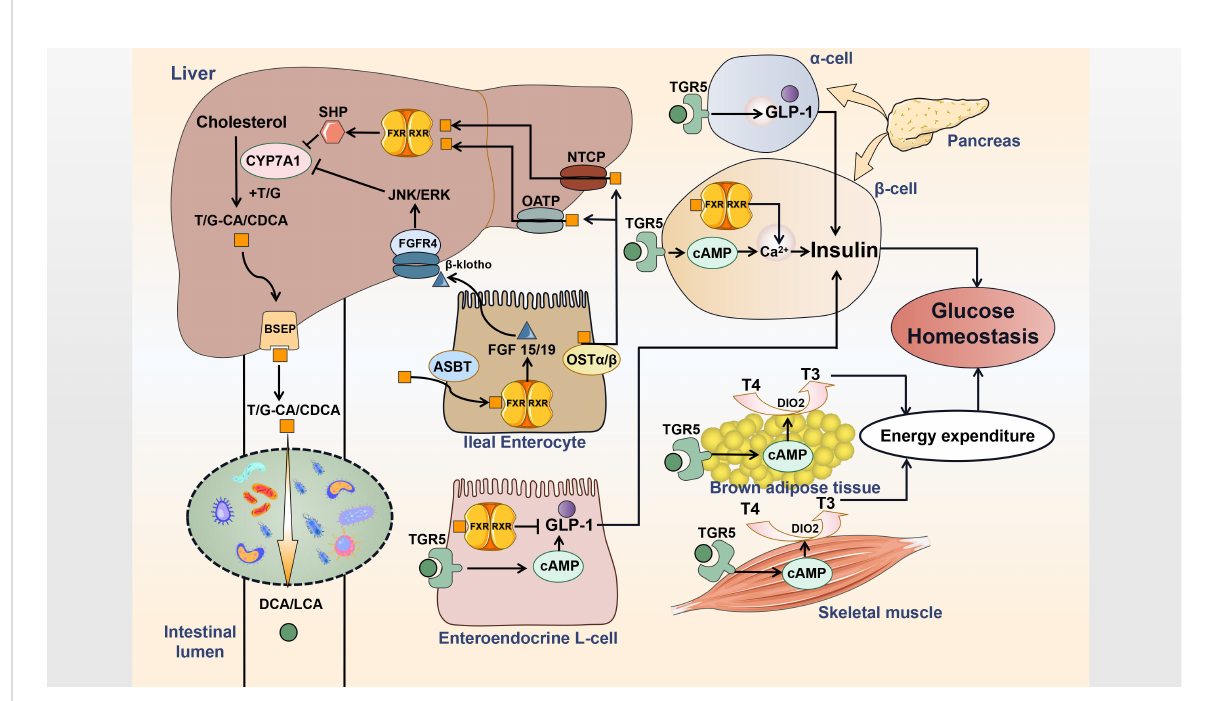
FIGURE 1 Interactions of BAs and gut microbe in fl uence host metabolism. Primary bile acids are synthesized and then conjugated with taurine or glycine in hepatocytes. Conjugated bile acids are transported into the bile duct by BSEP. Most conjugated bile acids are reabsorbed via ASBT and circulate to the liver by OST a / b , OATP and NTCP, while a small part is converted into secondary bile acids by deconjugation and dehydroxylation of gut fl ora. Bile acids acts as the endogenous ligands for FXR and TGR5 to generate distinct effects on metabolism regulation. T, taurine; G, glycine; CA, cholic acid; CDCA, chenodeoxycholic acid; DCA, deoxycholic acid; LCA, lithocholic acid; BSEP, bile salt export protein; FGF, fi broblast growth factor; FGFR, FGF receptor; RXR, retinoid X receptor; SHP, small heterodimer partner; JNK, c-Jun N-terminal kinase; ERK, extracellular signal-regulated kinase; OST, organic solute transporter; OATP, organic anion-transporting polypeptide; NTCP, sodium taurocholate cotransporting polypeptide; ASBT, apical sodium-dependent bile acid transporter; DIO2, type 2 iodothyronine deiodinase; T4, thyroxine; T3, thyroid